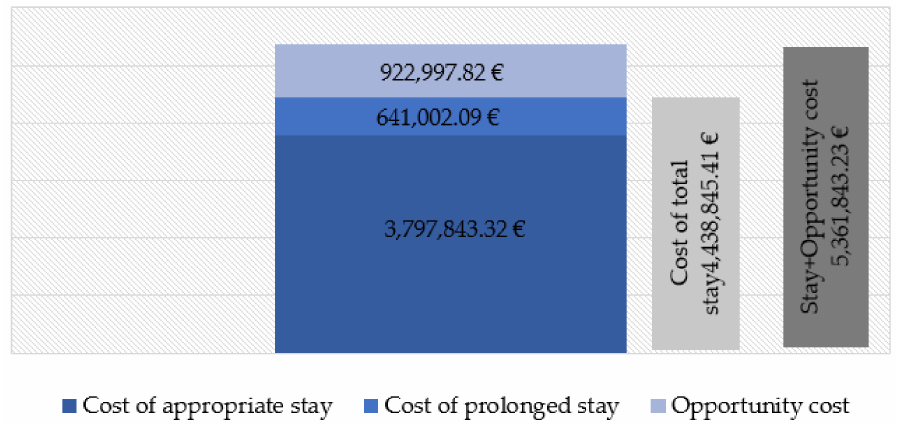
Figure 1. Costs of delayed discharge for non-clinical reasons in hip procedures. Model 1: according to actual hospital stays. Cantabria (northern Spain), 2007–2015.